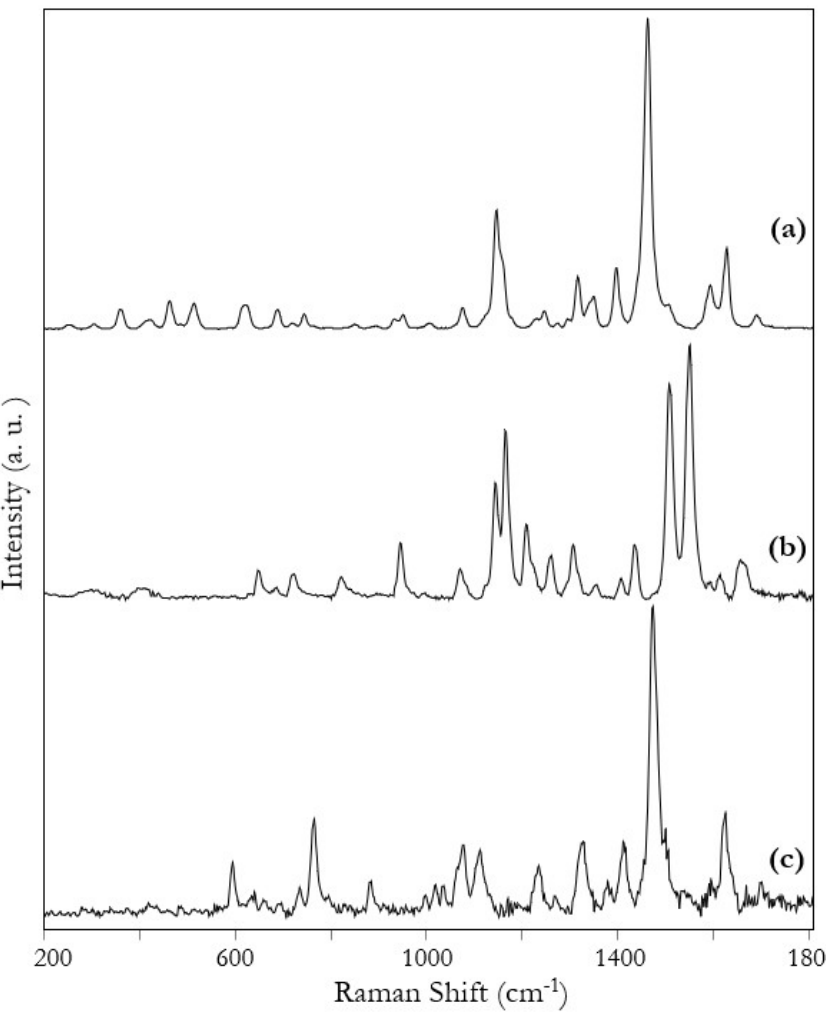
Figure 2. SSE™ Raman spectra of pure powdered ( a ) cyan, ( b ) yellow and ( c ) magenta dyes. Satisfying results were obtained also by SERS spectroscopy upon visible excitation at 532 nm (Figure 3). The interaction between the dye molecules and the silver nanostars, in fact, leads to the enhancement of the Raman scattering and to the quenching of the fluo- rescence emission. As expected, a correspondence was found between SERS and Raman spectra of the same dyes, despite small shifts of band positions and variations in the in- tensity ratios (Figure S3 Supporting Information). Tentative assignment of Raman and SERS bands are reported in Table 1. The main SERS signals are attributable to the vibra- tional modes of the C=O, C=C, and C=N bonds, as shown in the table. Furthermore, for the magenta dye 2 the bands assigned to the β(C–H) modes in the normal Raman spectra are absent in the SERS spectra, thus suggesting that the dye molecule adopts a flat-on geometry with respect to the silver nanoparticles and the main interaction between the molecule and the nanoparticles occurs through the conjugated system [25]. In fact, the substantial coplanarity of the phenyl, pyrazolone, and p-diethylaminophenyl rings was demonstrated in the literature by crystallographic studies for a molecule containing a me- thyl group instead of the benzoyl amide group [26]. It is interesting to note, however, that the azomethine yellow dyes belonging to the class of the compound synthesized in the present work are known to have generally less planar molecular structures [4]. In partic- ular, for a molecule similar to 1 , except for a methyl group on the p-diethylaminophenyl ring and a chlorine atom on the phenyl ring of the carbamoyl moiety, crystallographic